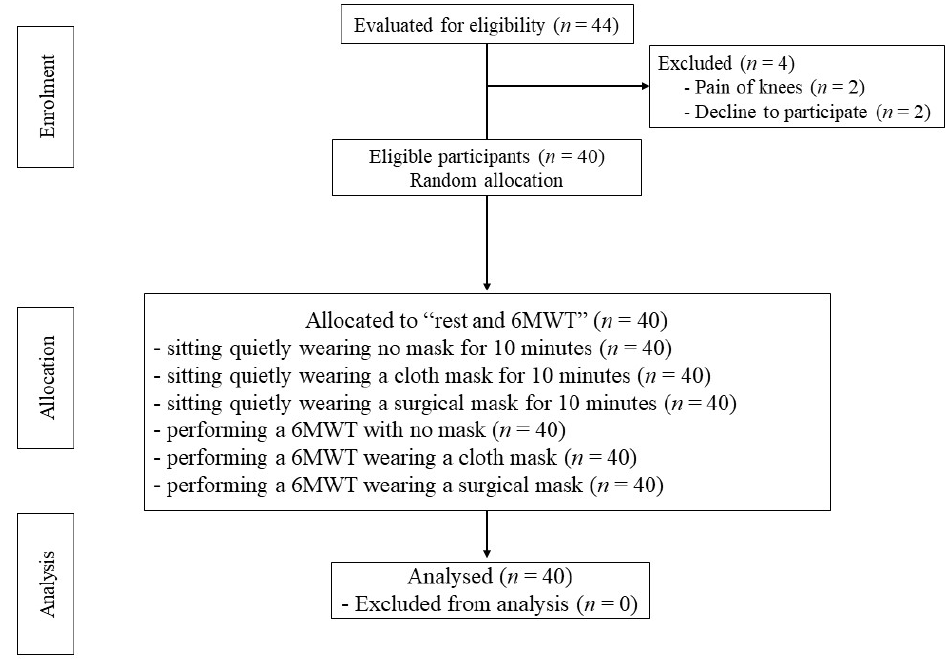
Figure 1. A flow diagram of the participants through each stage of this study.